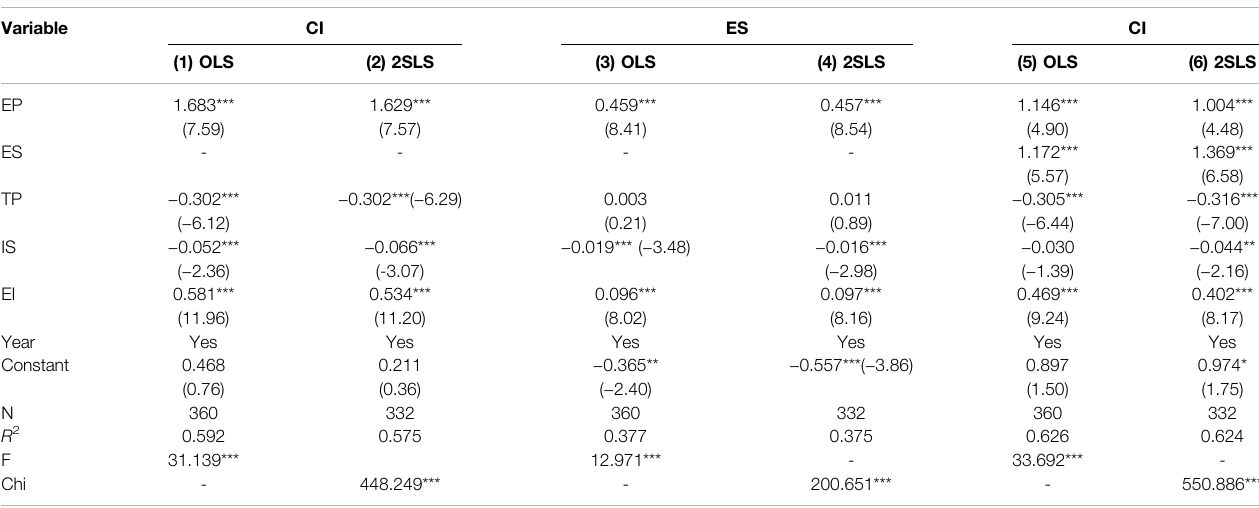
TABLE 4 | Main effect and mediation effect test results.